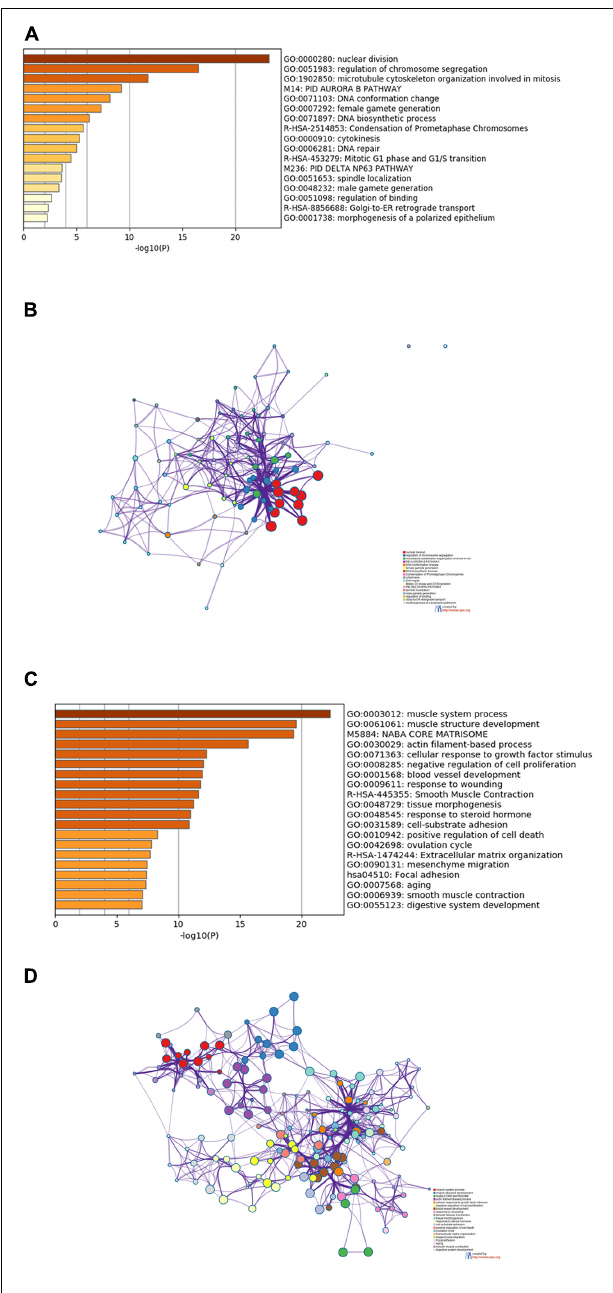
FIGURE 2 | Results of functional and pathway enrichment analyses. (A) Bar graph of the top 20 enriched terms of upregulated genes. (B) Interaction network of upregulated genes, containing 20 sets of enrichment results. (C) Bar graph of the top 20 enriched terms of downregulated genes. (D) Interaction network of downregulated genes, containing 20 sets of enrichment